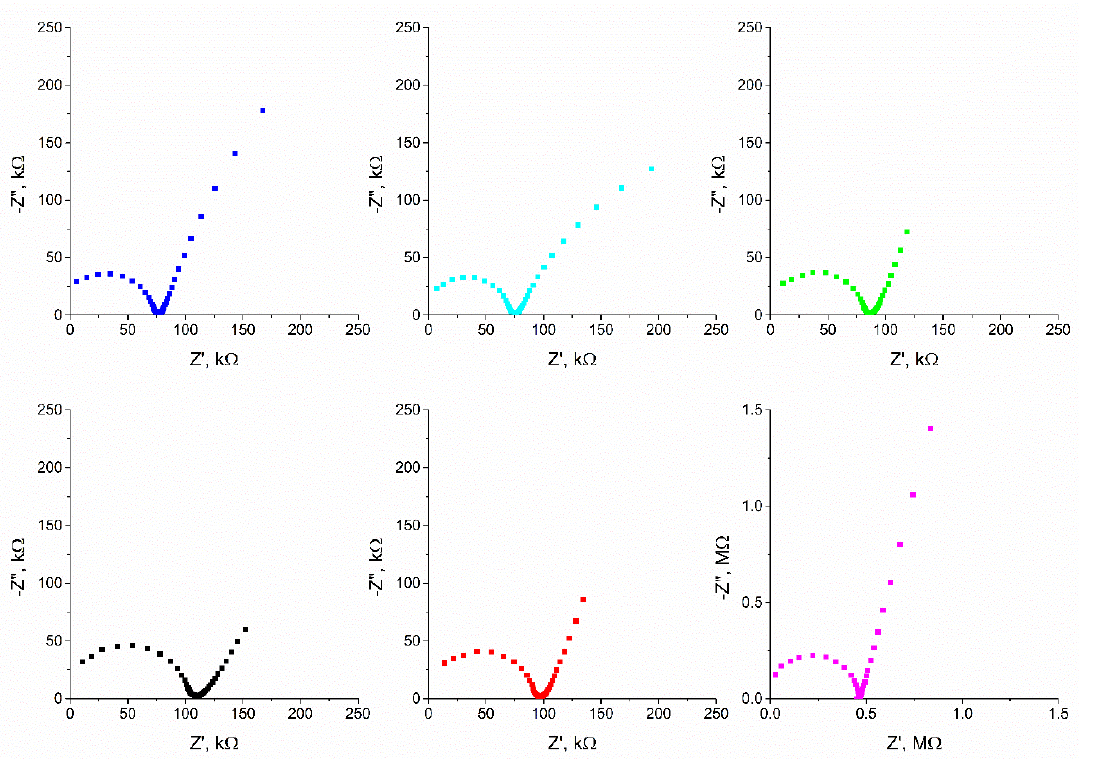
Figure 10. Nyquist plots of a GC/eCNF/K + ‐ ISM (blue), GC/eCNF ‐ Co/K + ‐ ISM